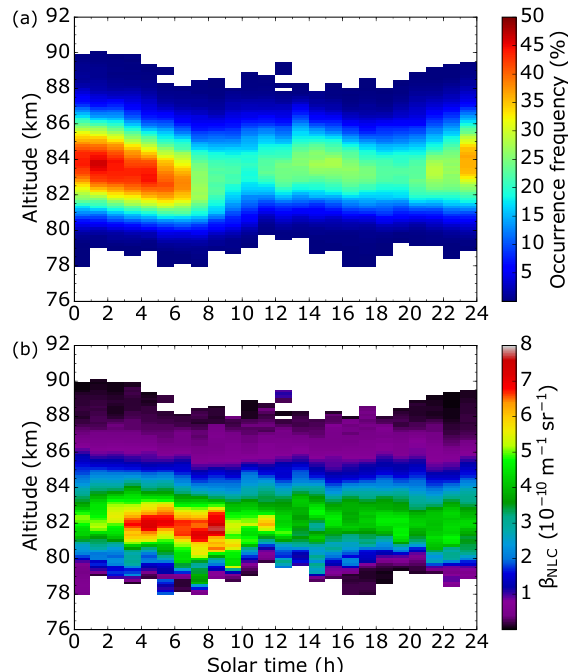
Figure 1. Mean altitude and solar time variations of NLC occur- rence frequency (a) and brightness (b) between 1 June and 15 Au- gust from 1997 to 2017. The plots are composed of altitude profiles covering 3100h of NLC detections; panel (a) contains 6400h total measurement